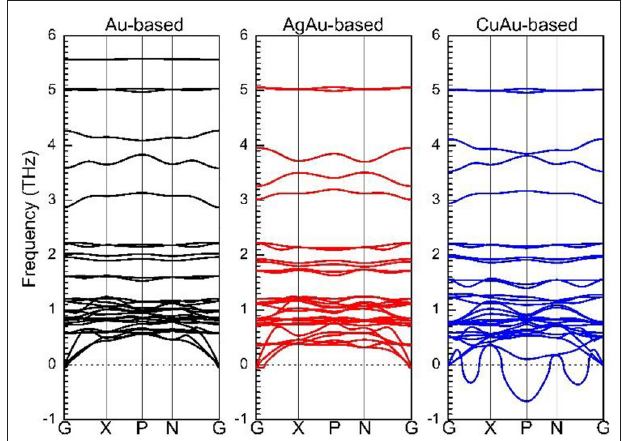
FIGURE 4 | Calculated phonon spectra of Cs 2 Au 2 I 6 , Cs 2 AgAuI 6 , and Cs 2 CuAuI 6 , respectively.